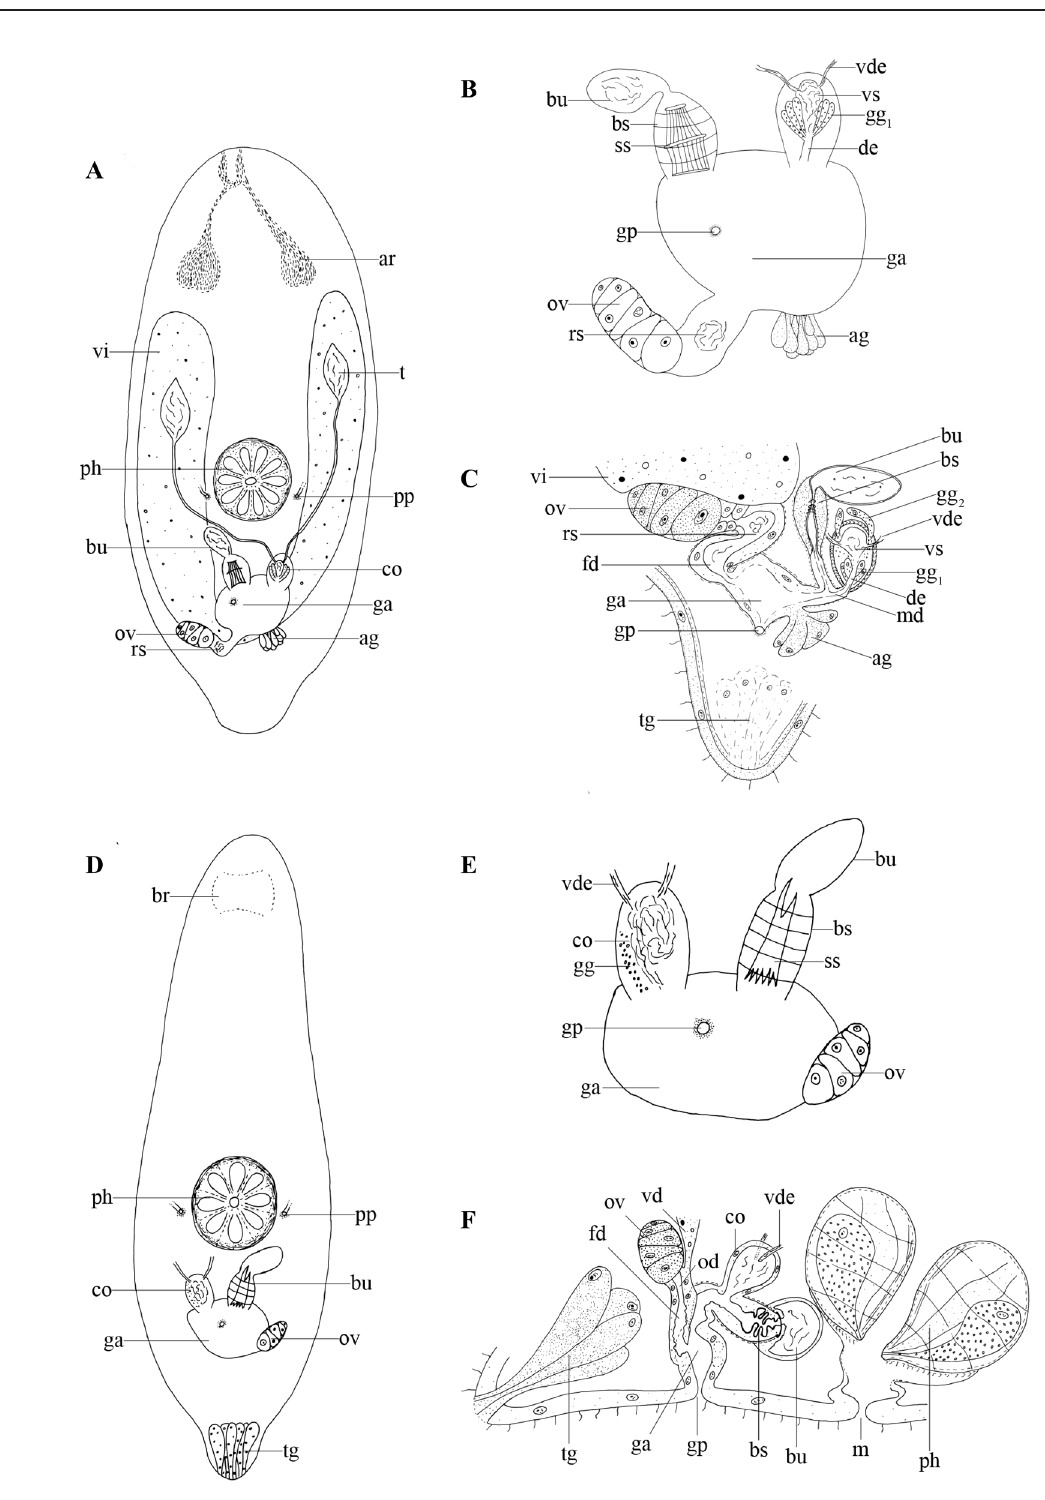
Fig. 7. Two species of Hoplopera Reisinger, 1924. A–C . Hoplopera isis Houben, Proesmans & Artois sp. nov. A . Internal organisation of a live specimen. B . Organisation of the genital system of a live specimen. C . Reconstruction of reproductive organs based on horizontal sections. D–F . Hoplopera opaca Reisinger, 1924. D . Internal organisation of a live specimen. E . Organisation of the genital system of a live specimen. F . Reconstruction of reproductive organs based on sagittal